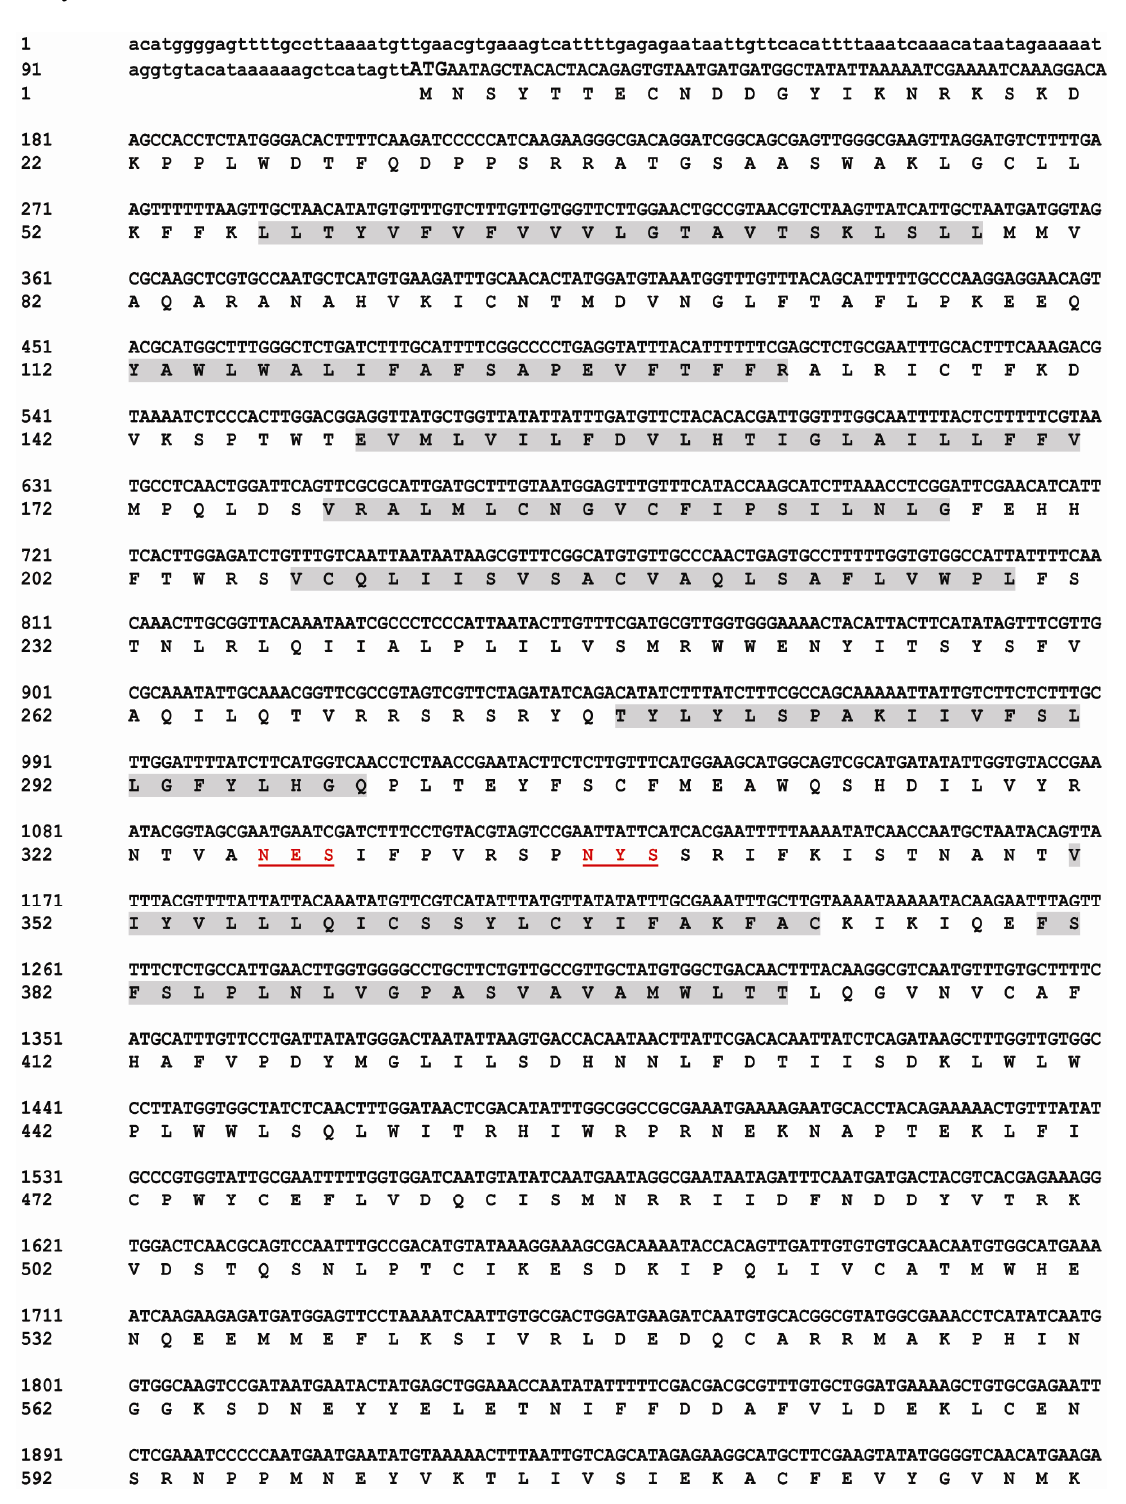
Figure 1. Nucleotide and deduced amino acid sequences of BdCHS2 cDNA from Bactrocera dorsalis (KC354694). The start codon is indicated in bold and the stop codon in bold with an asterisk. The putative polyadenylation signal (AATAA) is boxed. The putative transmembrane regions are shaded. The five potential N -glycosylation sites are double underlined. The amino acid sequence of the putative catalytic domain is in gray with black background. The signature sequences (EDR and QRRRW) are in white with a wavy